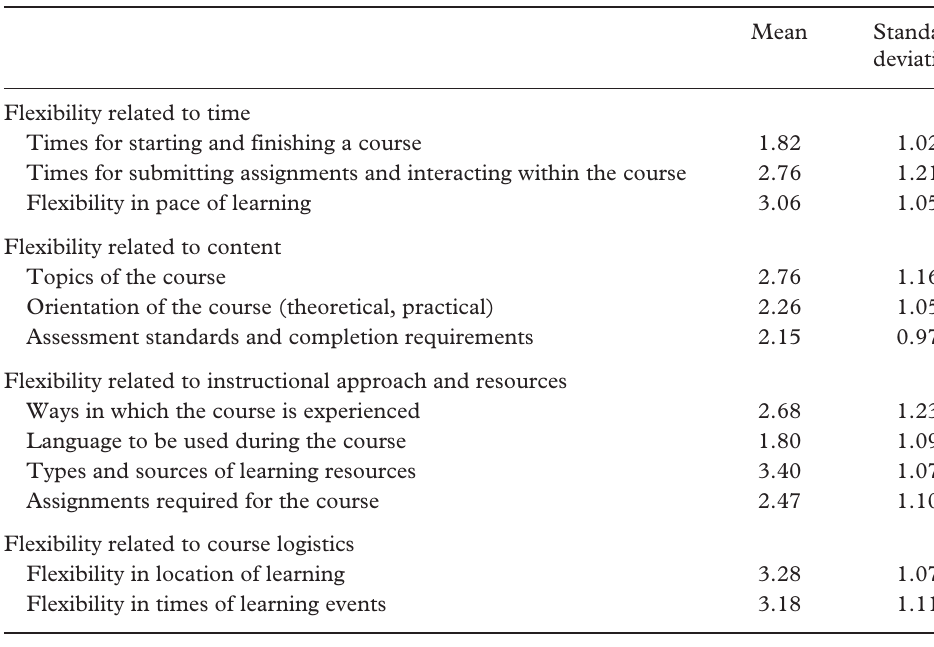
Table 2. Amount of flexibility within courses currently offered by instructors within their own courses in higher education ( n =